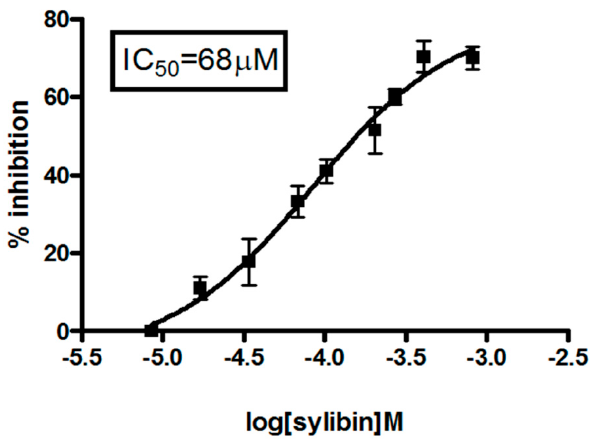
Figure 1. Dose-response effects of silybin on HCC cells. HepG2 cells were seeded and treated with different concentrations of Silybin (0–200 mM) for 72 h, and thereafter cell viability was assessed as described in “Materials and Methods”. The experiment was repeated three times and the results are the mean of the different data. Bars represent standard deviations.